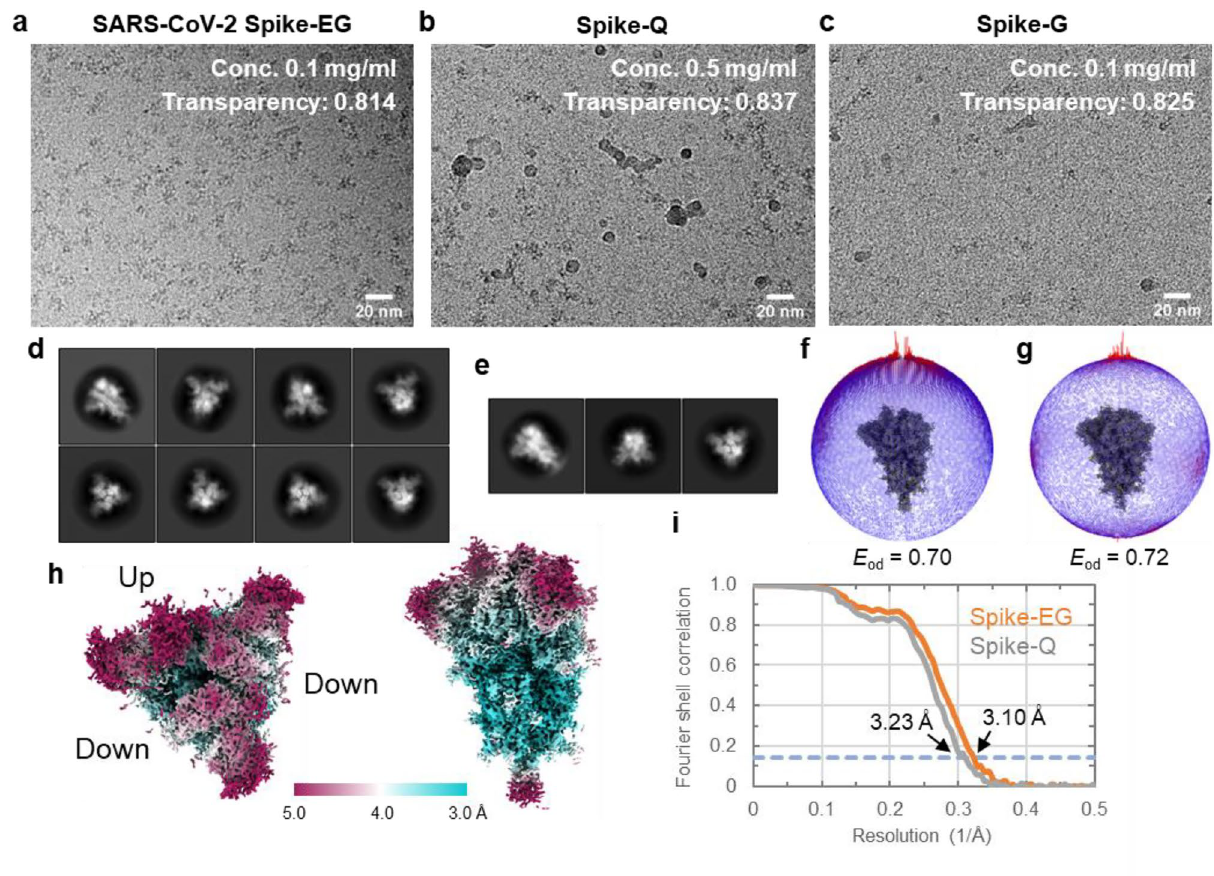
Figure 4. CryoEM image analyses of SARS-CoV-2 spike protein on the EG-grid and Quantifoil grid. ( a – c ) Typical cryoEM images of spike protein on the EG-grid (spike-EG) ( a ), on the Quantifoil grid (spike-Q) ( b ), and on the glow discharged graphene grid (spike-G) ( c ). The protein concentration and the value of electron beam transparency of each image (measured from the image brightness ratio between the energy filter slit in and out) are also shown. ( d and e ) Selected 2D class averages from the spike-EG dataset ( d ) and the spike-Q dataset ( e ). The class averages are aligned in descending order of particle numbers from left to right and top to bottom. ( f and g ) Angular distributions of particles used in the final refinement for the spike-EG dataset ( f ) and the spike-Q dataset ( g ). Final 3D maps are shown for reference. The efficiencies ( E od ) calculated with cryoEF are also shown. ( h ) Two orthogonal views of the final 3D map from the spike-EG dataset: top view of the trimer, left panel; and side view, right panel. The local resolution distribution is colored as in the color bar. ( i ) The FSC curves for the final maps of the spike-EG and spike-Q dataset. The dashed blue line indicates the FSC = 0.143